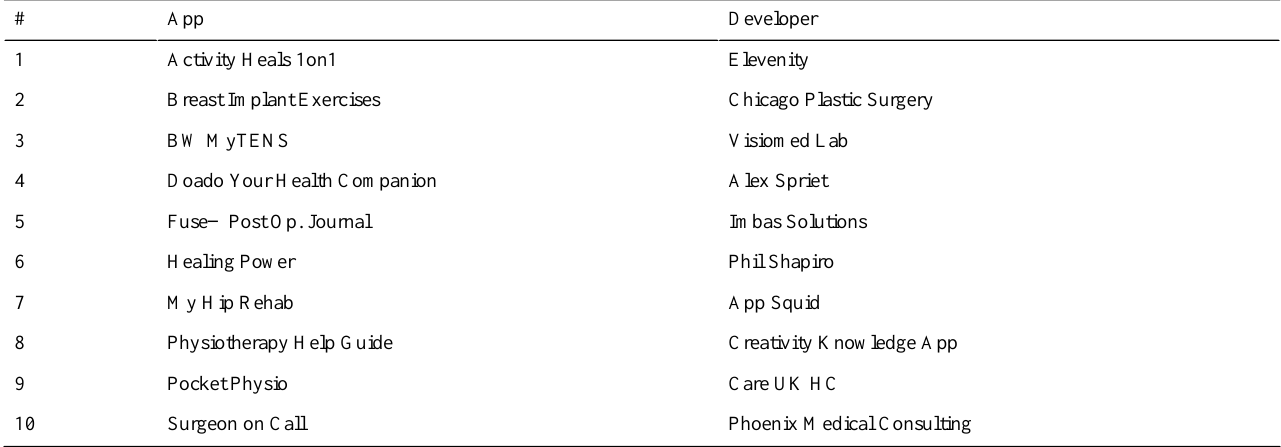
Table 1. Postoperative pain apps included in the